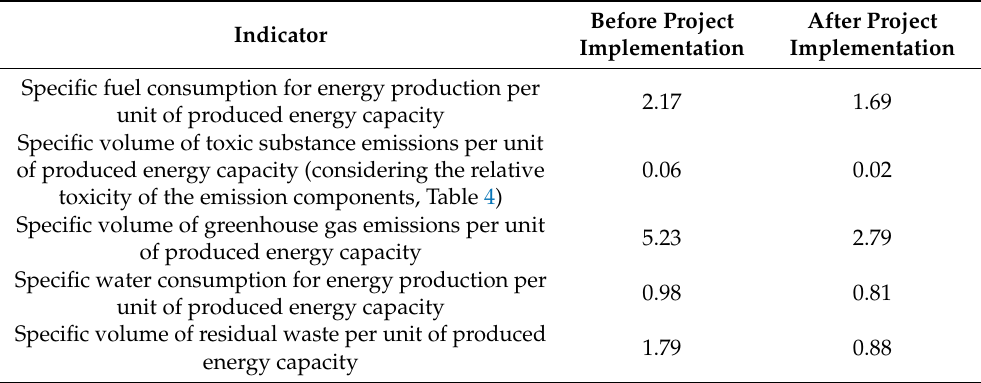
Table 5. Calculations of specific performance indicators of CHP X before and after project implementation. Indicator